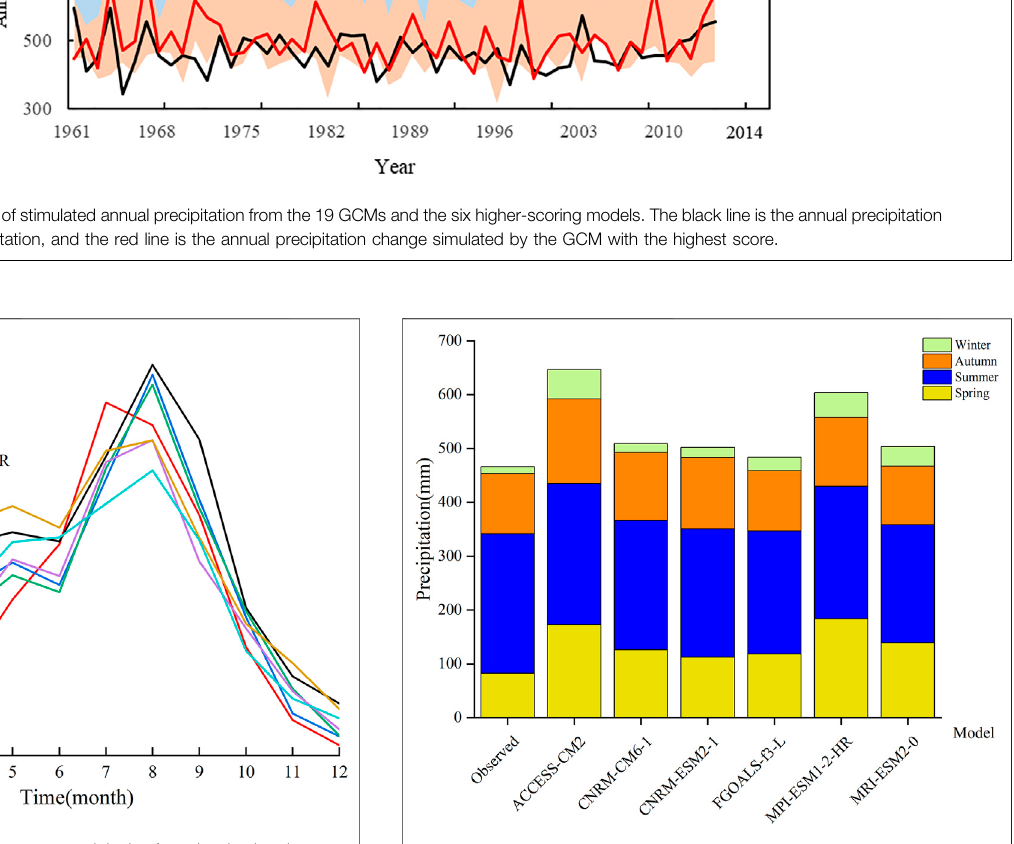
FIGURE 7 | Seasonal precipitation of the observation and simulation from the six higher-scoring GCMs, spring is from March to May, summer is from June to August, autumn is from September to November, and winter is from December to